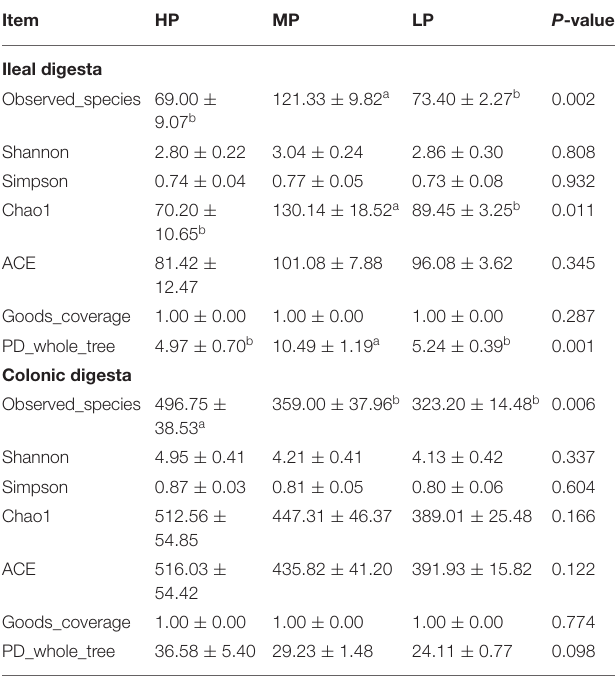
TABLE 8 | Effect of low protein diet on the α -diversity of gut microbiota in finishing